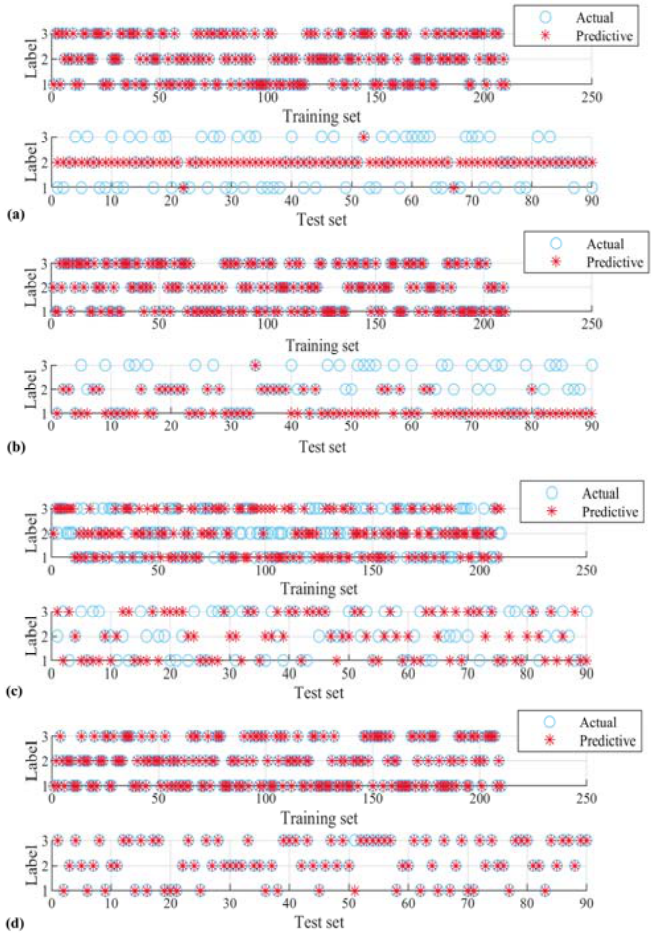
Figure 6. Identification results of two models for three groups of aviation alloy samples. ( a ) SVM; ( b ) SM–PSO; ( c )LSSVM; ( d ) LSSVM–PSO.